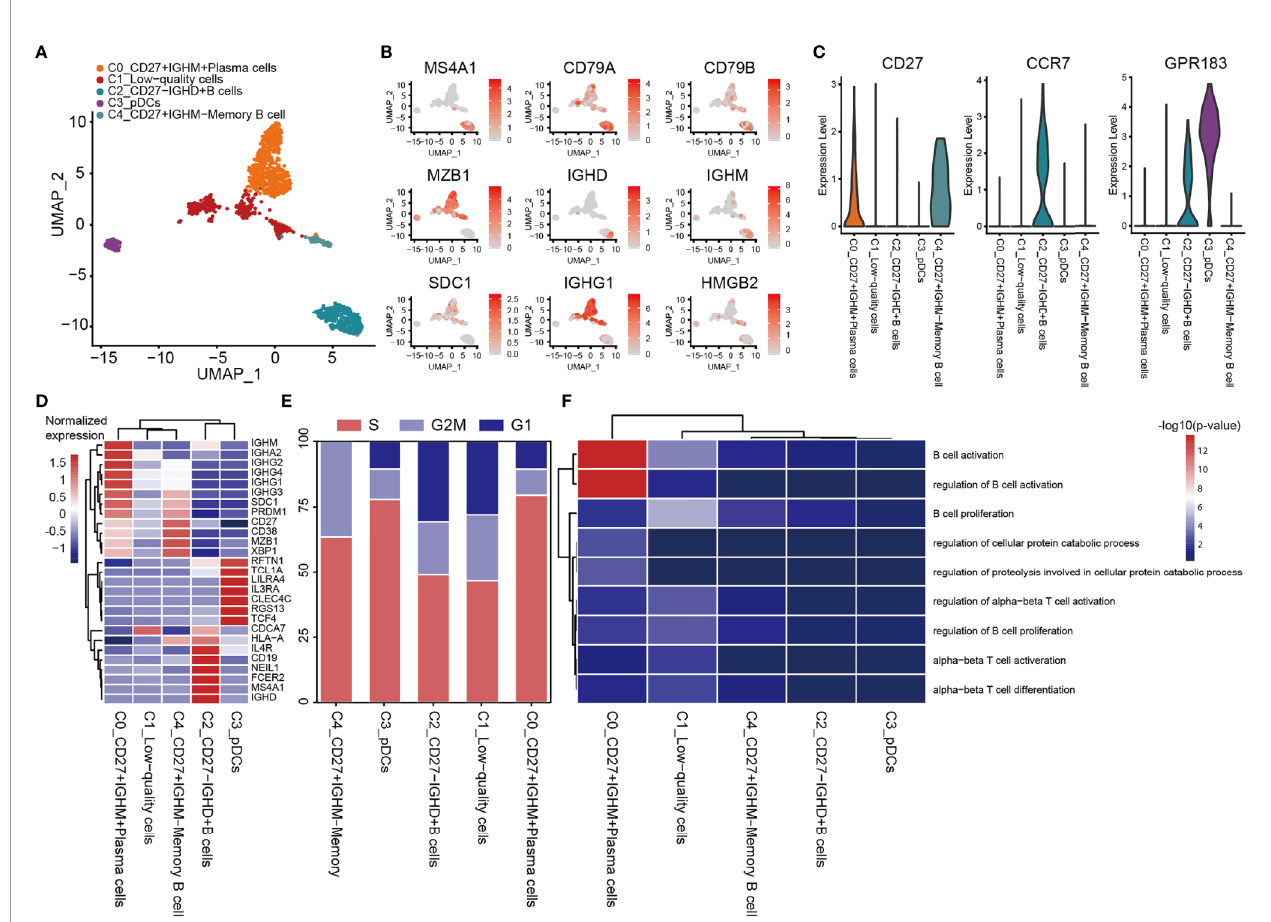
FIGURE 7 | Heterogeneity of B cell populations in OS. (A) UMAP plot showing B cells, with different cell types represented by the different colors. (B) Cell types are de fi ned by known genes the red color represents genes expressed, with gray representing no genes expressed. (C) Violin plots, showing relevant marker genes of B cells. (D) Heat map showing the marker genes of each cluster, with the selected B cell marker genes in each cluster highlighted. (E) Fractions of cells for the B cell subclusters are shown, with predicted cell cycle phases. (F) GO analysis, showing the function of subpopulations of B cells. OS, osteosarcoma; UMAP, uniform manifold approximation and projection; GO, gene